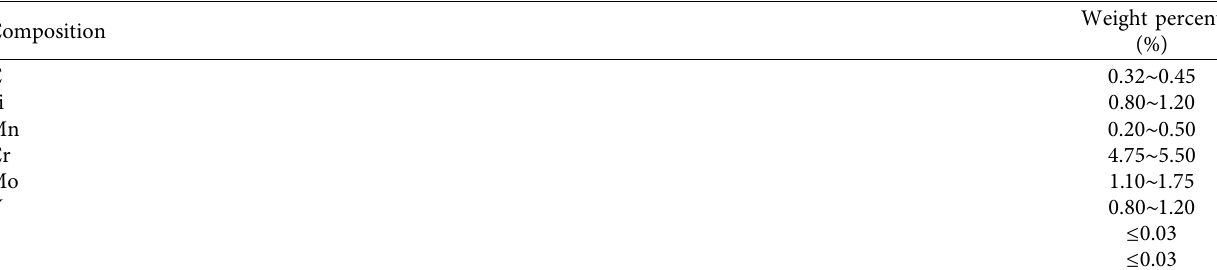
Table 2: Chemical composition of AISI H13.